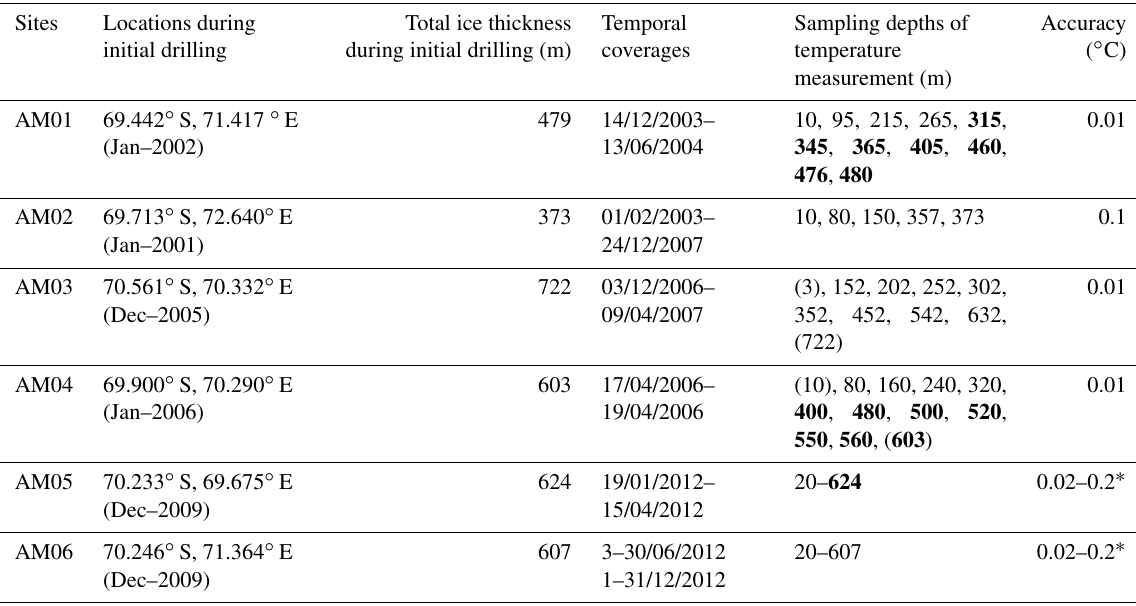
Table 1. Details of the borehole thermistor data at sites AM01–AM04 and DTS data at sites AM05 and AM06 in the AIS. The DTS conducts continuous temperature measurements with a spatial sampling interval of 1.015m. Temperatures at sampling depths marked in parentheses are estimated using the available regional AWS data and surface temperature field (Comiso, 2000) or in situ pressure melting temperature as appropriate; depths in bold are within the marine ice